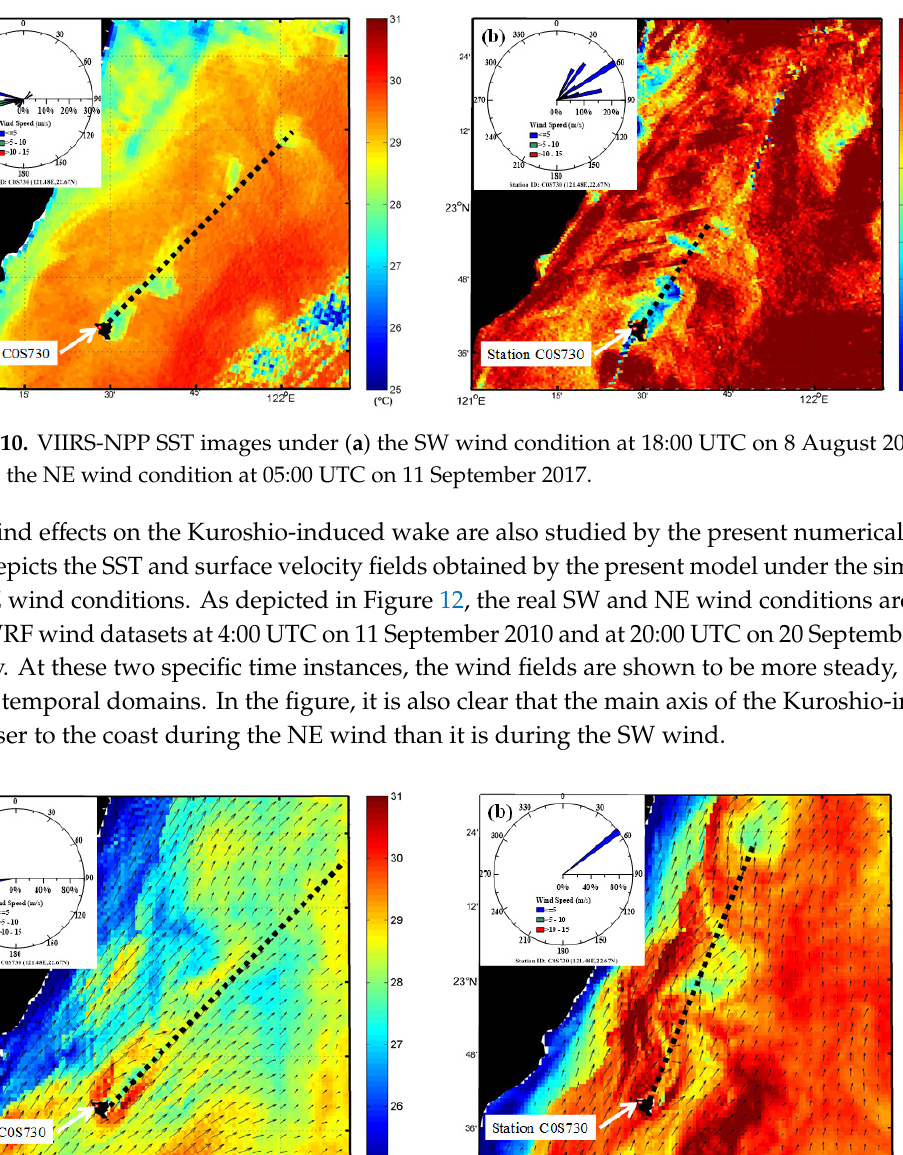
( b ) the NE wind condition. Figure 11. Numerical SST and velocity fields under ( a ) the SW wind condition and